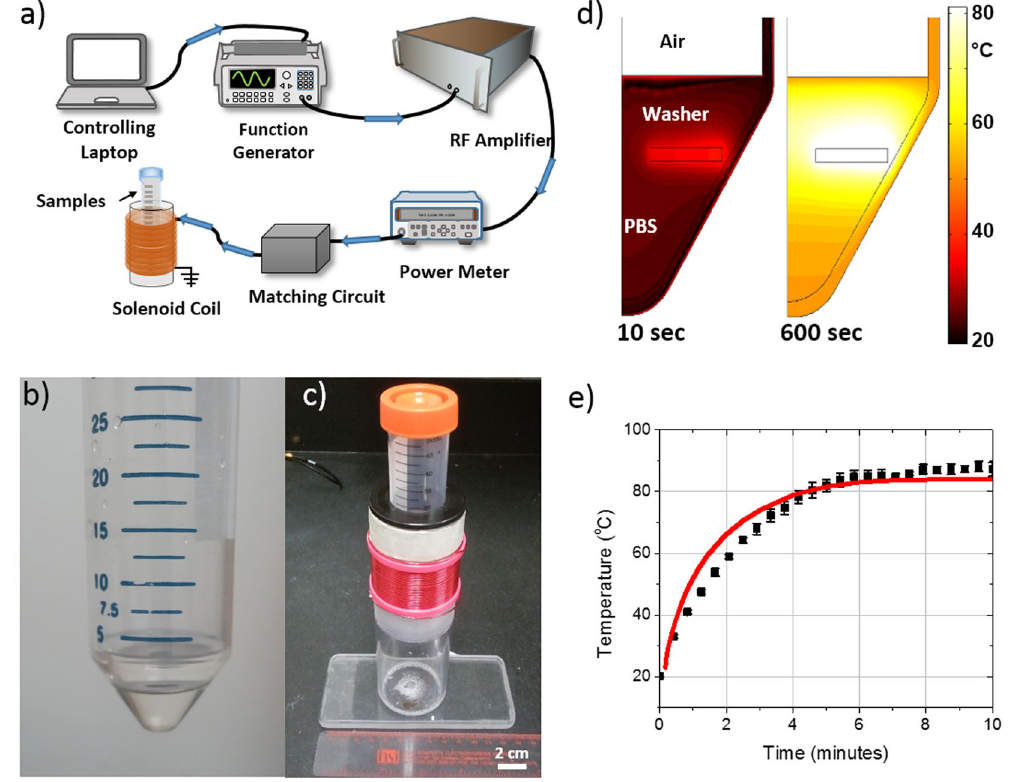
Figure 2. A custom-built solenoid was used to expose metal washers with biofilm to an alternating magnetic field (AMF). ( a ) Under PC control, 20 W was delivered to a solenoid coil at a frequency of 500 kHz. ( b ) Stainless steel washers with biofilm were placed at the bottom of a 50 ml centrifuge tube with 4 ml of PBS. ( c ) The centrifuge tubes were inserted into the center of the solenoid exposed to an AMF for different durations. ( d ) Finite-element simulations depict the spatial temperature distribution inside the centrifuge tube after 10 and 600 seconds of AMF exposure. ( e ) Fiber-optic temperature measurements of the surface of the washer (squares) during a 10 minute AMF exposure show a steady increase in temperature until a steady state value is approached at 6 minutes. The predicted temperature increase from finite-element simulations (red line) and the fiber optic measurements (black squares) agree with a root mean square error of 5.2